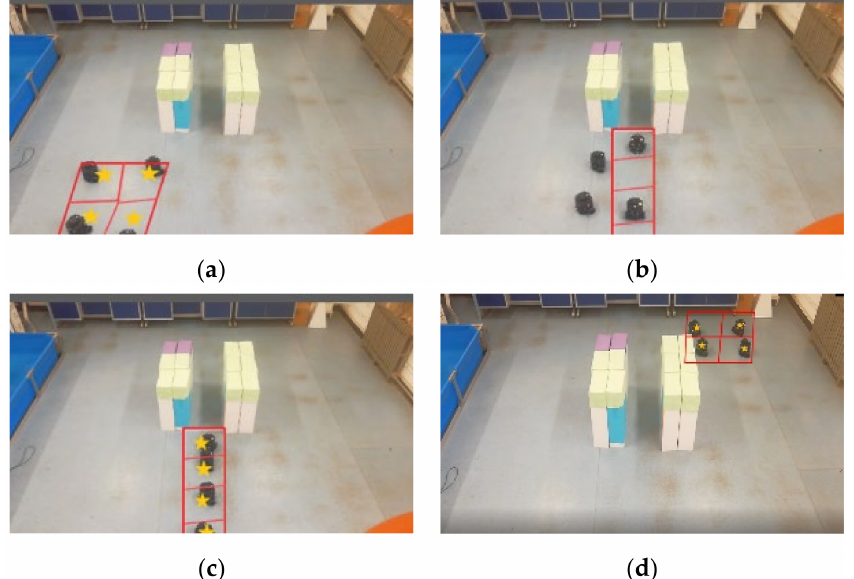
Figure 23. Multi-robot dynamic formation experiment in a narrow channel: ( a ) t 1 = 0 s; ( b ) t 2 = 48 s; ( c ) t 3 = 61 s; ( d ) t 4 = 207